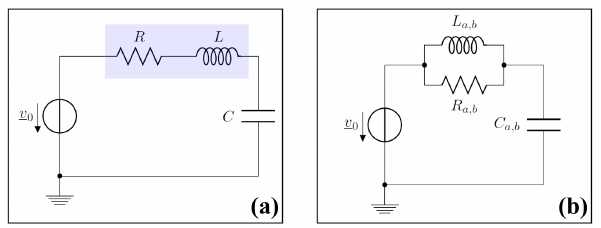
Figure 15. (a) Equivalent series resonance circuit for the circuit from Fig. 14 used to determine the effective properties of each reso- nance peak of the coupled system and (b) circuit model representing an effective